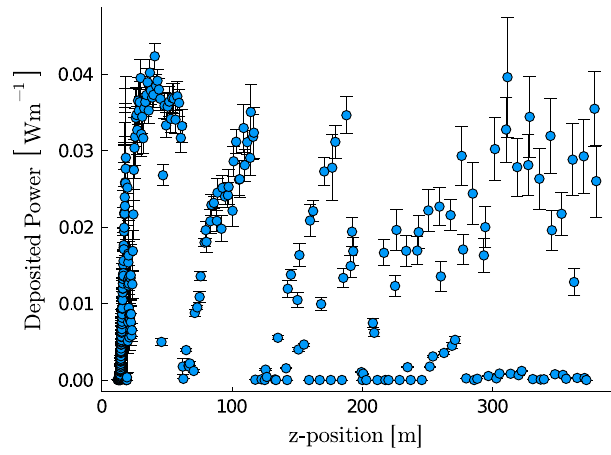
FIG. 6. Power deposition of H 0 into beam-pipe and machine element walls for a 62.5 mA H − beam accelerating to 2.5 GeVas in Fig. 4. Only IBST is accounted for.